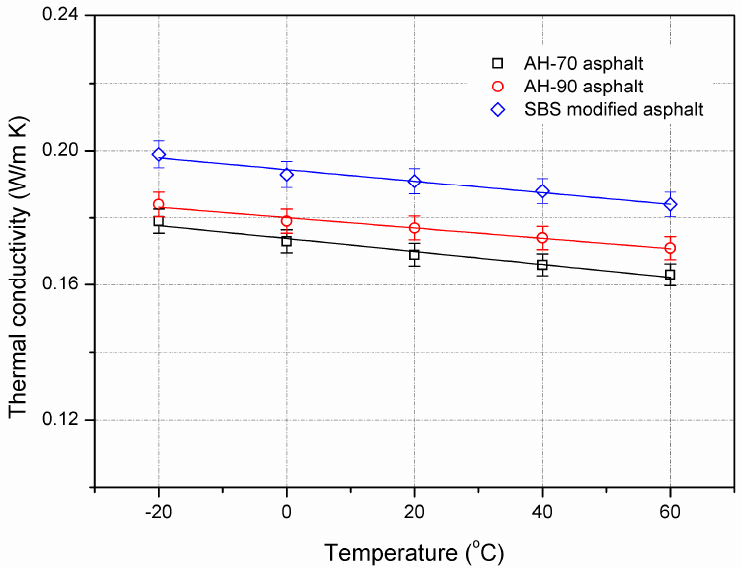
Figure 4. Effect of temperature on thermal conductivity of asphalt binders.